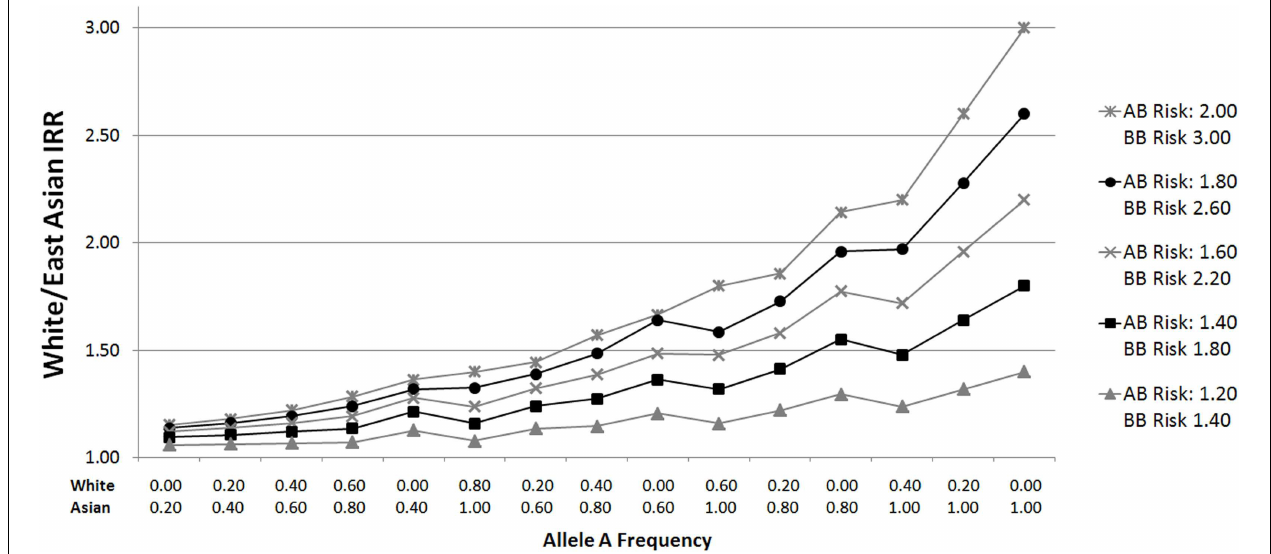
FIGURE 1 |White/EastAsian incidence rate ratios for varying allele distributions and genotypic relative risks. Plots were generated by calculating incidence rate ratios (IRRs) according to varying genotypic relative risks (GRR) and ethnic group allele frequencies. For example, suppose the GRR for glioma for persons with one B allele is 2.00, and the GRR for persons with two B alleles is 3.00 (relative to those homozygous for the A allele). If the frequency of allele A inWhites is 0.20 (p = 0.2), the proportions of AA (p 2 ), AB